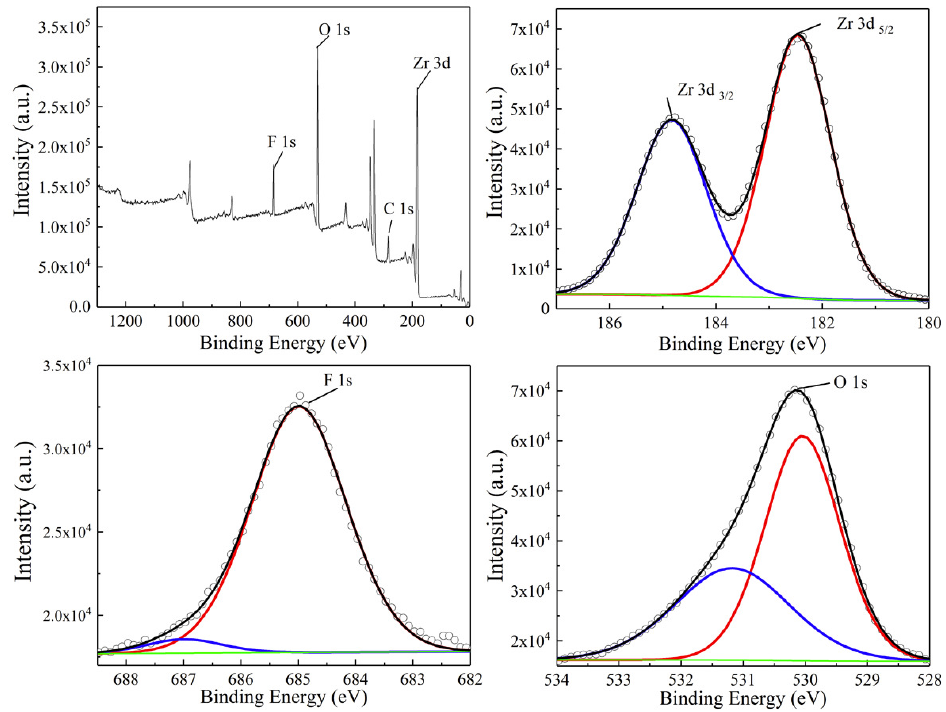
Figure 4. XPS survey and high resolution spectrums of HT-ZrO 2 (0.01)